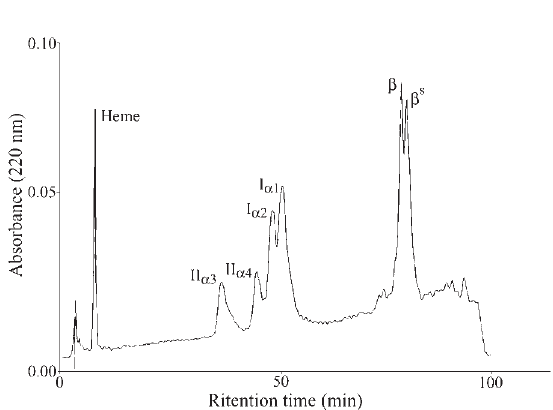
Figure 3 - Reversed-phase high performance liquid chromatography of lysates of ABA s B s Hb phenotype. The numbering of the α chains is the same as that of the associated Hb tetramers in Figure 1.